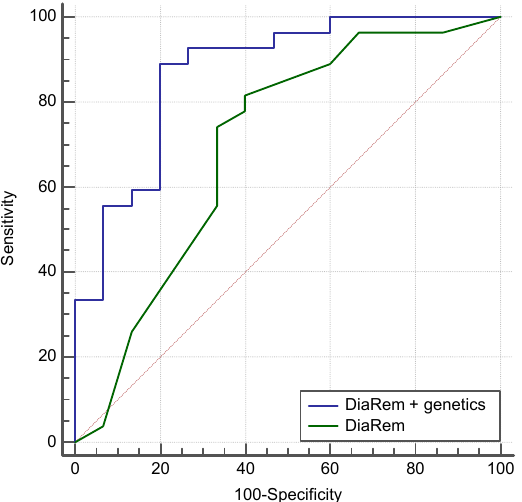
Figure 3. The predictive capacity of the DiARem score and the combination between DiARem and genetics in our study population. The AUROC for DiaRem was lower than obtained by genetic test (0.69 versus 0.86), and when both scores were combined the AUCROC was 0.87, with a sensitivity of 88.49% and a specificity of 80.00%.